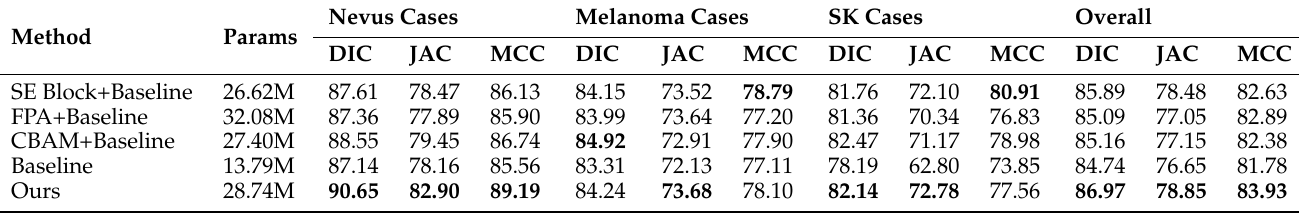
Table 6. Performance evaluation of Jaccard coefficient, Dice coefficient and Matthew correlation coefficient of different attention modules and CSFAG modules on the ISIC-2017 data set using baseline as the basic structure. Bold data indicates that the value is the maximum value in this